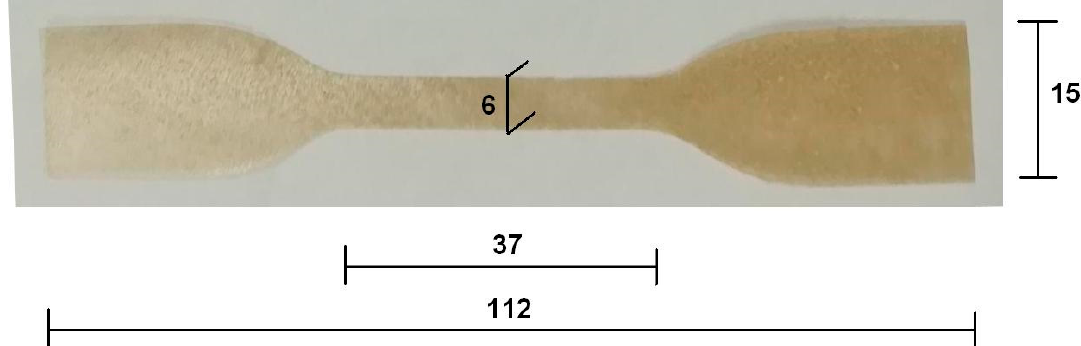
Figure 2. Example of a tensile dog-bone specimen (quotes in mm with tolerance ± 0.1 mm).